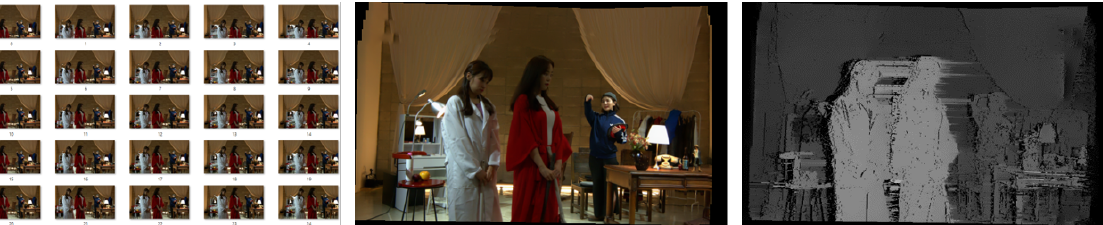
Figure 19. View synthesis with 25 images is extended in the vertical and horizontal direction.